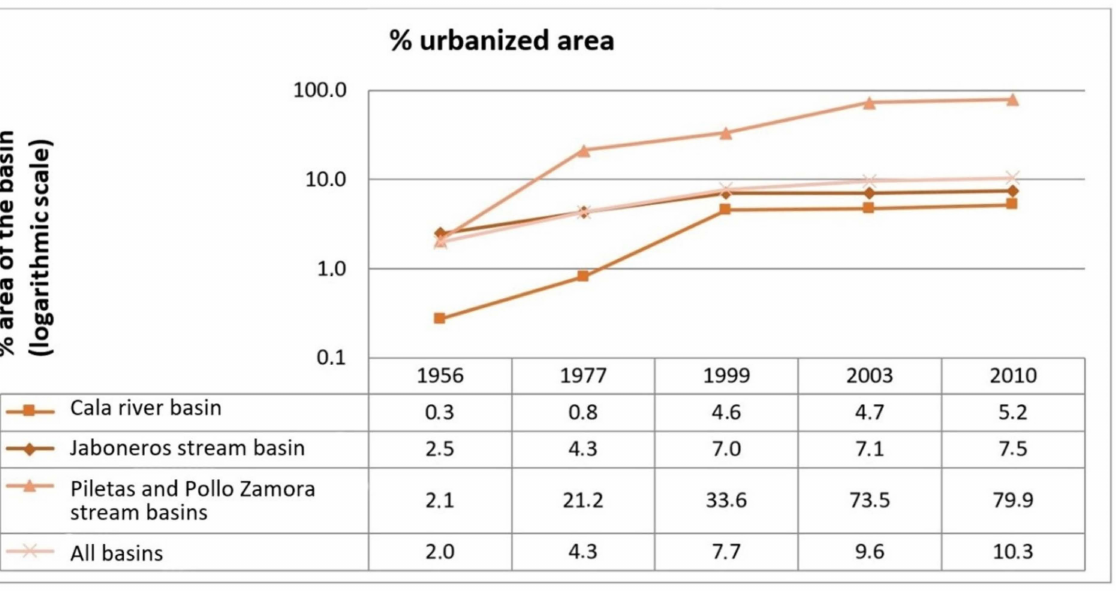
Figure 6. Evolution of the urban land in the basins between 1956, 1977, 1999, 2003, and